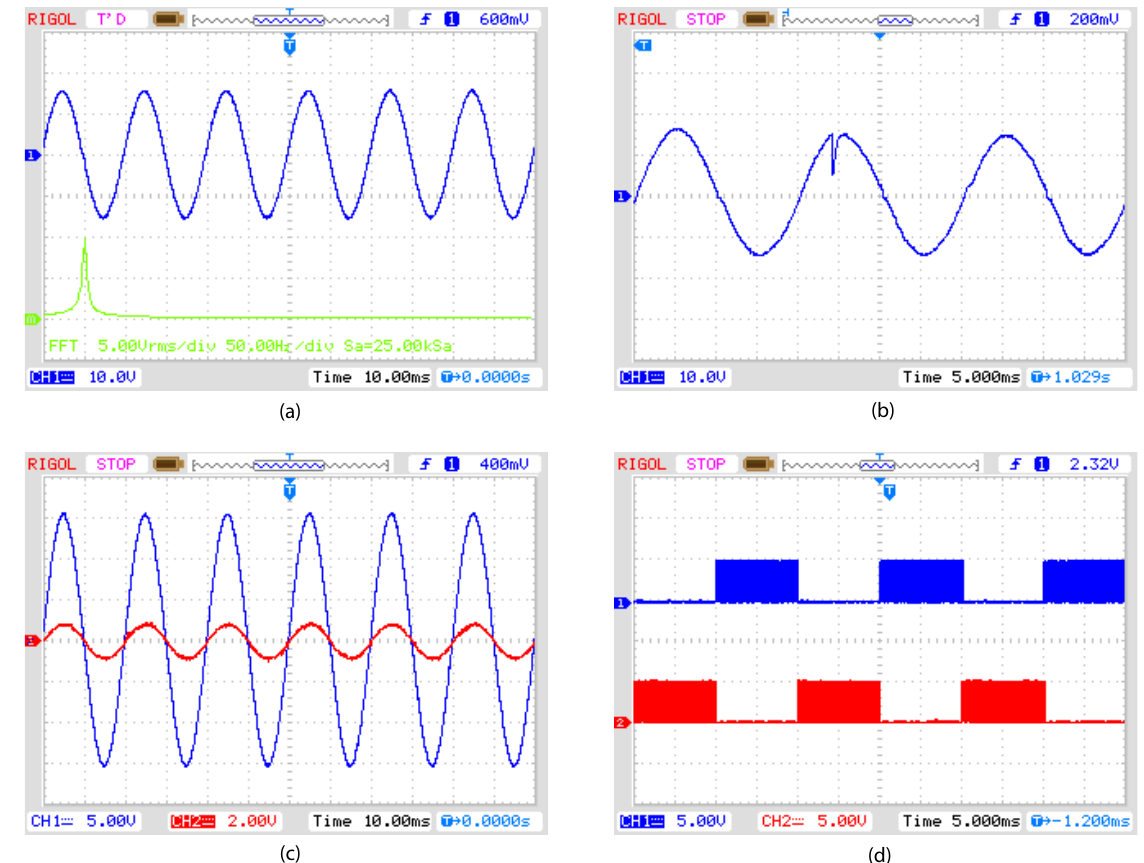
Figure 8. Waveforms of the experimental results. ( a ) FFT analysis of output voltage ( b ) Transient response of output voltage indicating robustness when load is shifted from 100 Ω to 9.1 Ω . ( c ) Output voltage and current of inverter. ( d ) Switching signals for gate driver to operate inverter in a closed-loop